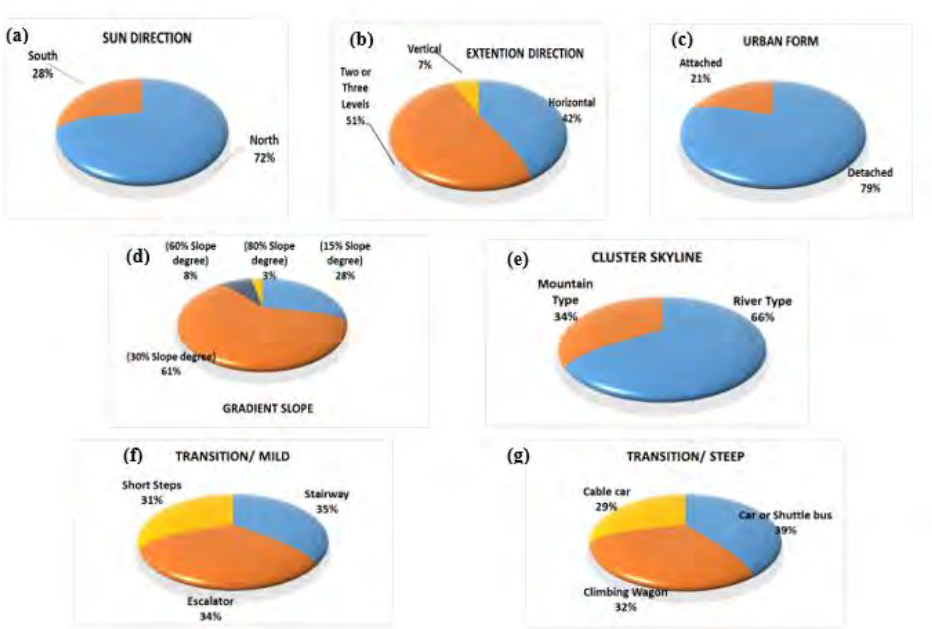
Figure 4. Urban design considerations recommended by Egyptian experts, for the Earth-sheltered neighborhoods.